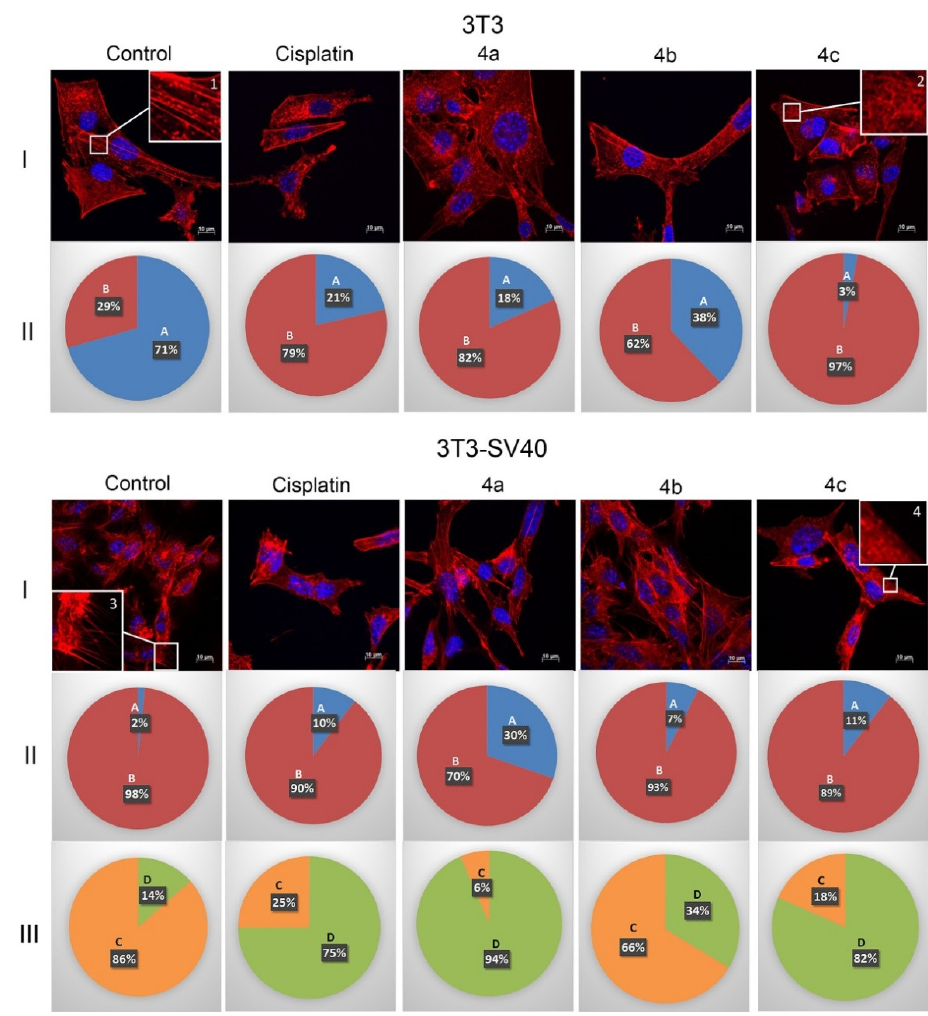
Figure 3. State of actin cytoskeleton of 3T3 and 3T3-SV40 cells after treatment with spiro-fused [3-azabicyclo[3.1.0]hexane]exindole derivatives 4a-c and cisplatin. I: Images demonstrate the different stages of cell actin cytoskeleton (I-3T3 and I-3T3-SV40). II: Pie charts demonstrate percentage of cells with normal stress fibers ( А ) and disassembled stress fibers ( В ) (II-3T3 and II-3T3-SV40). III: Pie charts demonstrate percentage of cells with filopodia-like deformations (C), and without filopodia-like deformations (D). Inserts: 1—stress fibers; 2—disassembled stress fibers; 3—filopodia-like deformations; 4—without filopodia-like deformations.